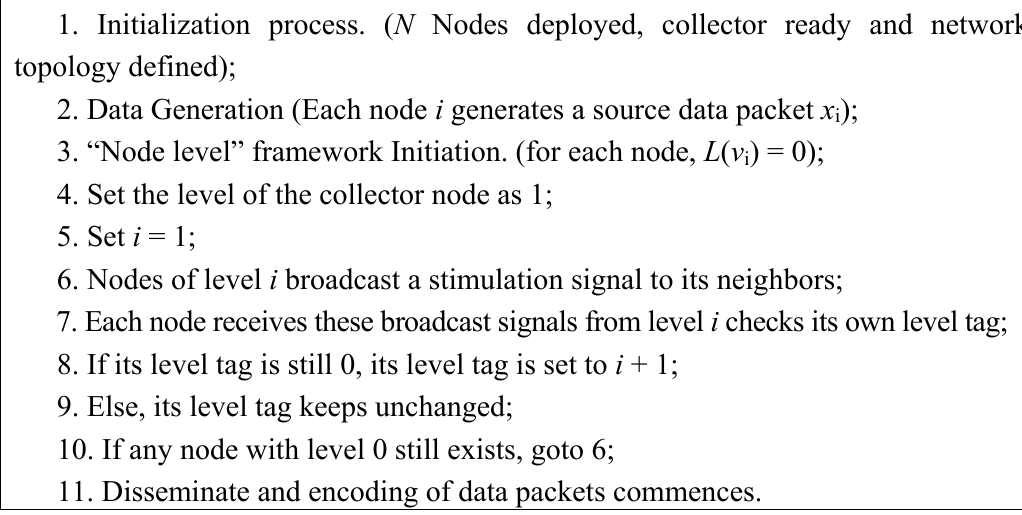
Algorithm 1. The full “node level” construction